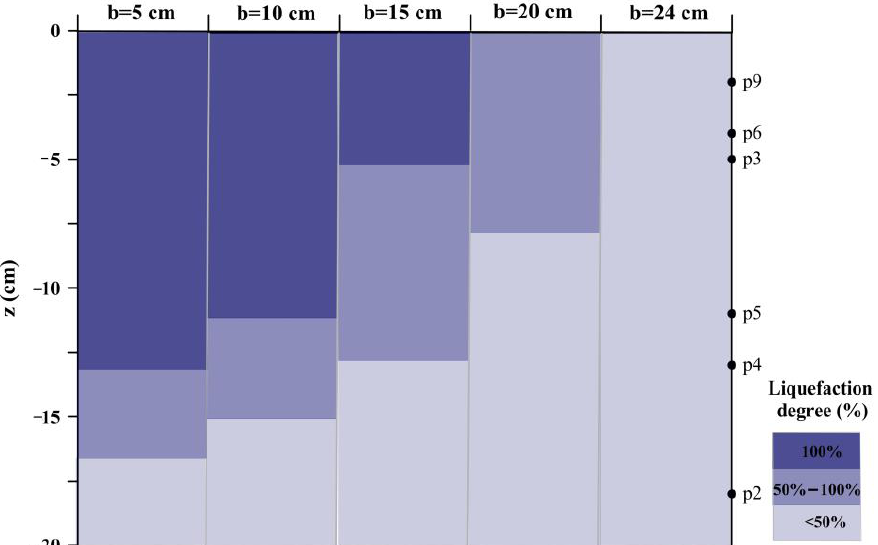
Figure 9. Variation in degree of soil liquefaction over soil depth and the burial depth of the pipeline in all the experimental tests. The pipeline was loaded with equivalent periodic loading (F = 55.3 N) in Tests 3 and 9 – 14 in this figure.